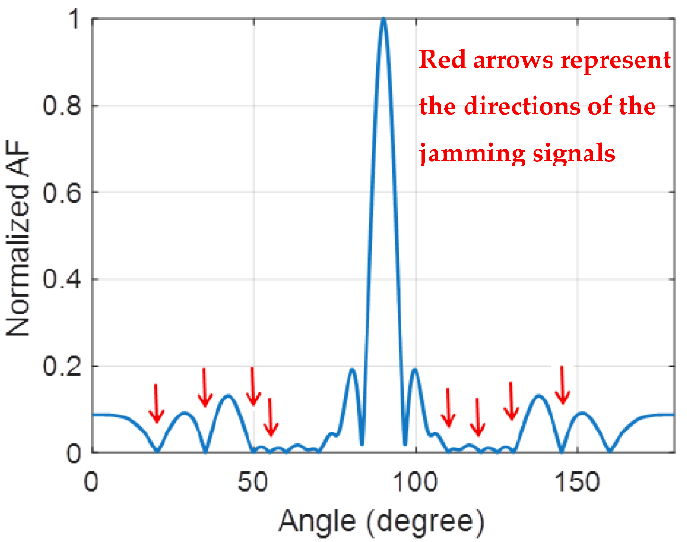
Figure 11. The normalized array factor for 20-element anti-jamming antenna by optimizing the excitation amplitude of the array antenna using FKE algorithm.